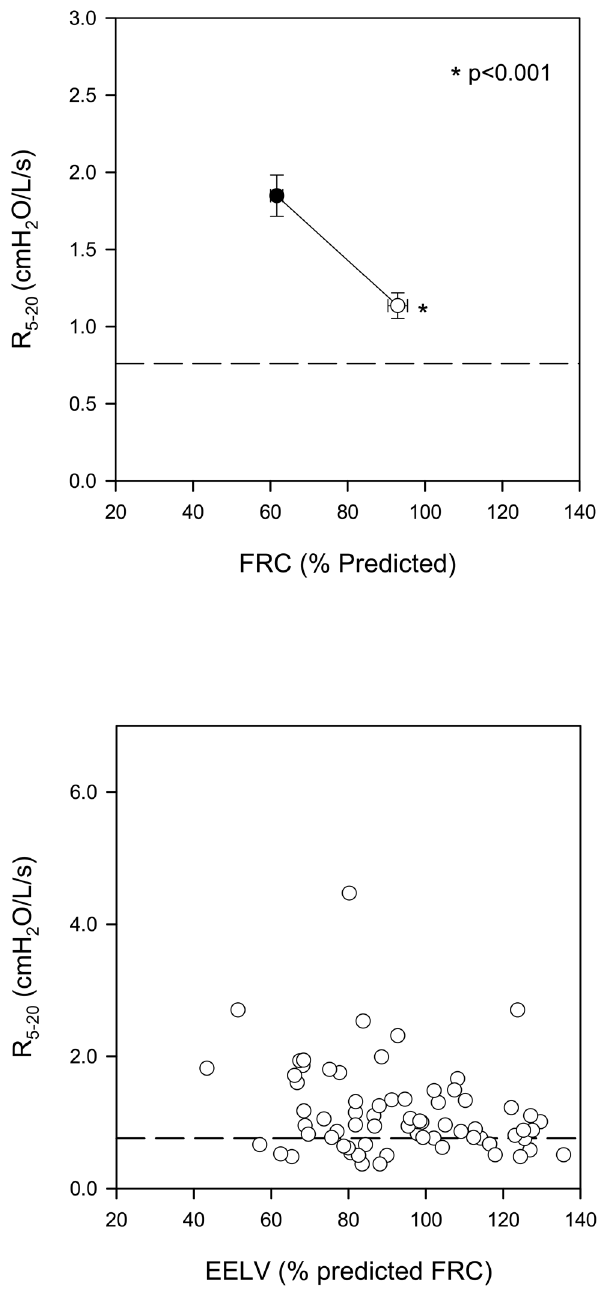
5 2 20 at baseline and during voluntary inflation. Data are mean 6 SE. Dotted line represents the upper limit of normal. Bottom Panel: Individual values obtained during voluntary inflation are plotted as a function of the absolute EELV at which it was obtained. EELV is expressed as % predicted FRC. Data are shown for 50/ N 71 patients in whom maneuvers were acceptable for analysis. Dotted =baseline # =voluntary line represents the upper limit of normal. (